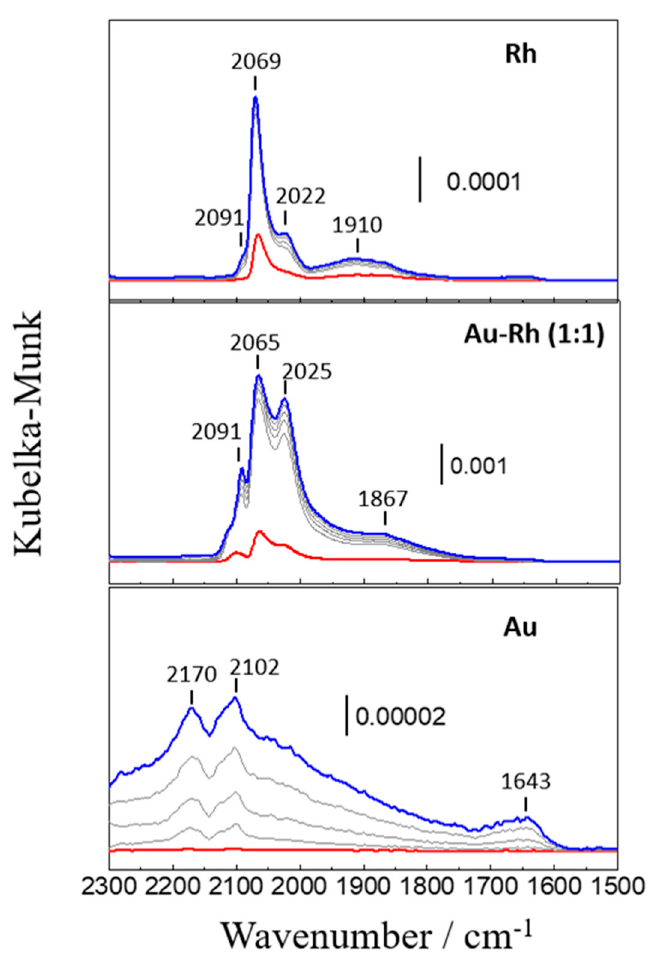
Figure 5. In situ diffuse reflectance IR spectroscopy (DRIFTS) spectra recorded during CO adsorption on the Rh/Al 2 O 3 , AuRh(1:1)/Al 2 O 3 , and Au/Al 2 O 3 catalysts at 30 °C for 5 min (from the red line to the blue line at an interval of 1 min). Gas mixture: 2000 ppm CO and He balance; total flow rate: 100 mL/min.